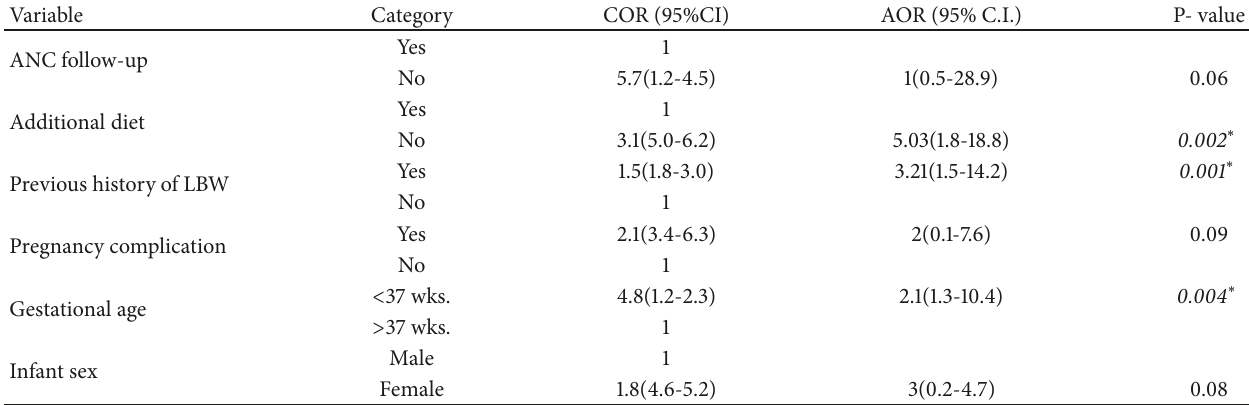
Table 3: Multivariable analysis results, factors affecting LBW among neonates delivered in Dangla Primary Hospital, Awi Zone, Amhara Region, Northwest Ethiopia, 2017 (n=232).